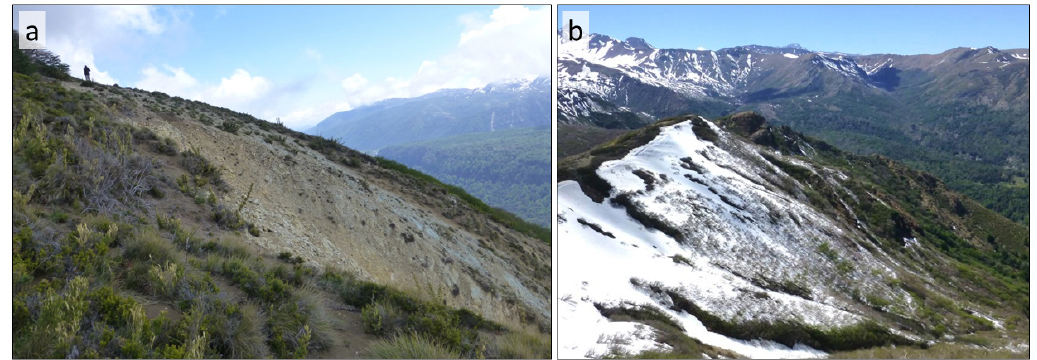
Figure 2. (a) Release area of avalanches, which in this particular track is also the initiation area of debris flows (df4; see Fig. 3 for reference). Just on the other side of the ridge ( b ; pictures taken the same day) we can observe a large amount of snow remaining from the previous